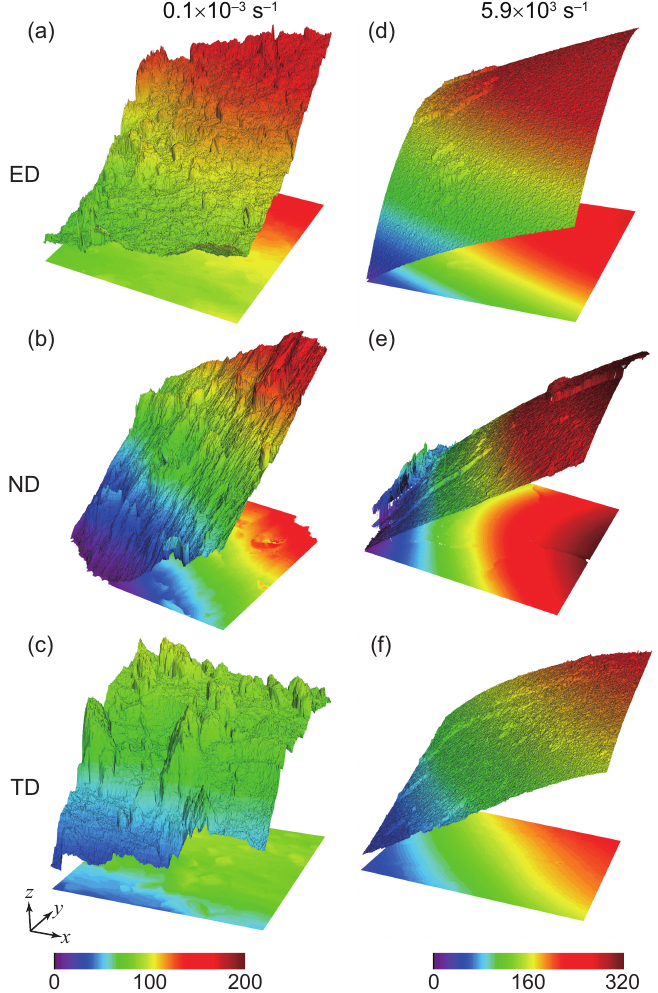
Figure 7. The 3D profiles of fracture surfaces for dynamic (5.9 × 10 3 s − 1 ; ( a – c )) and quasi-static (10 − 3 s − 1 ; ( d – f )) compression along the ED (the top row), ND (the middle row) and TD (the bottom line). The color-coding indicates the height value along the z